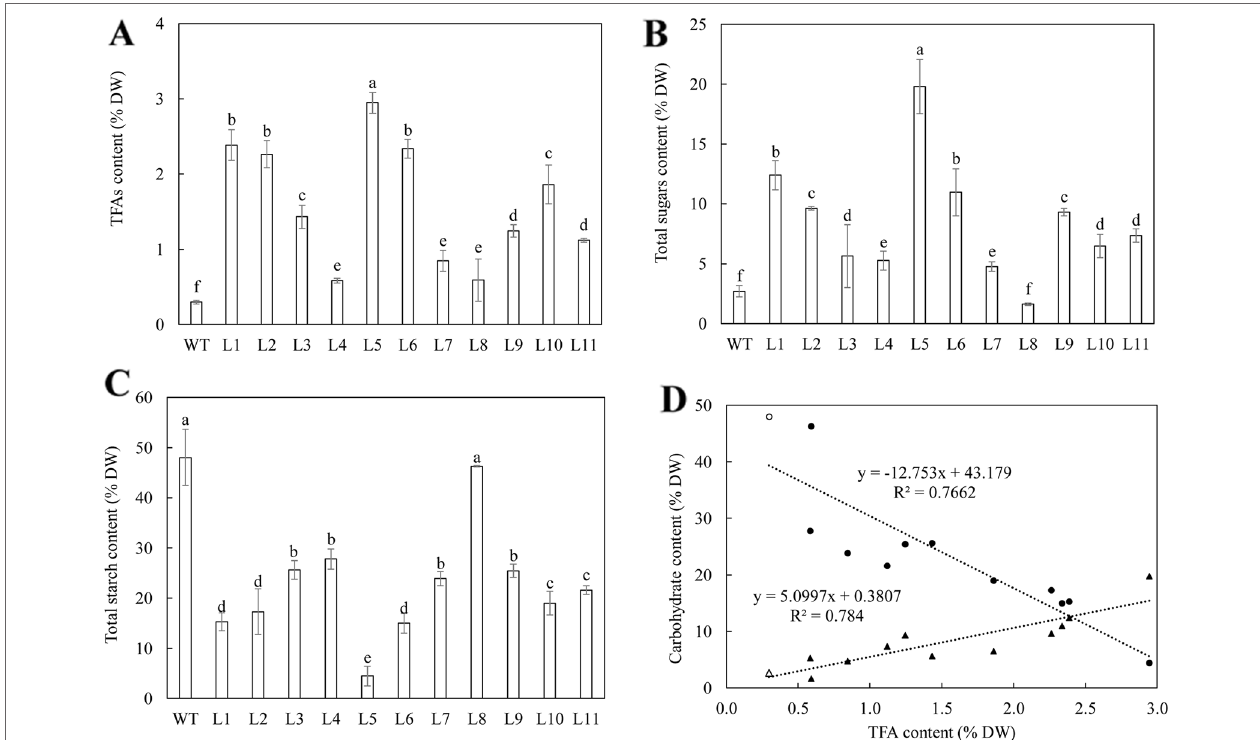
FigURE 1 | Contents of total fatty acids (TFA) and major carbohydrate in the mature potato tubers of WT and the eleven selected T 0 generation plants. (A) TFA content; (B) Total soluble sugars content; (c) Total starch content; (D) Regression analysis among TFA, total soluble sugars (triangles) and starch (circles) in WT (open symbols) and transgenic lines (black symbols). The relationship between TFA and starch is negative (y = -12.753x + 43.179, R² = 0.7662), while the relationship between TFA and the total soluble sugars is positive (y = 5.0997x + 0.3807, R² = 0.784). The data represent the mean values ± standard deviation (SD) of three biological replicates. Letters (a, b, c, etc.) above the bars are all based on the least significant difference (LSD). Different letters between lines are statistically significantly different at P <